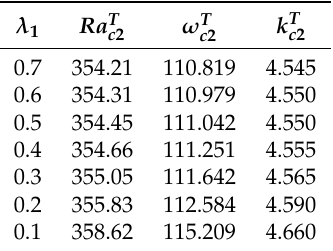
, frequency ω T and wave number k T at the onset of moving c 2 c 2 c 2